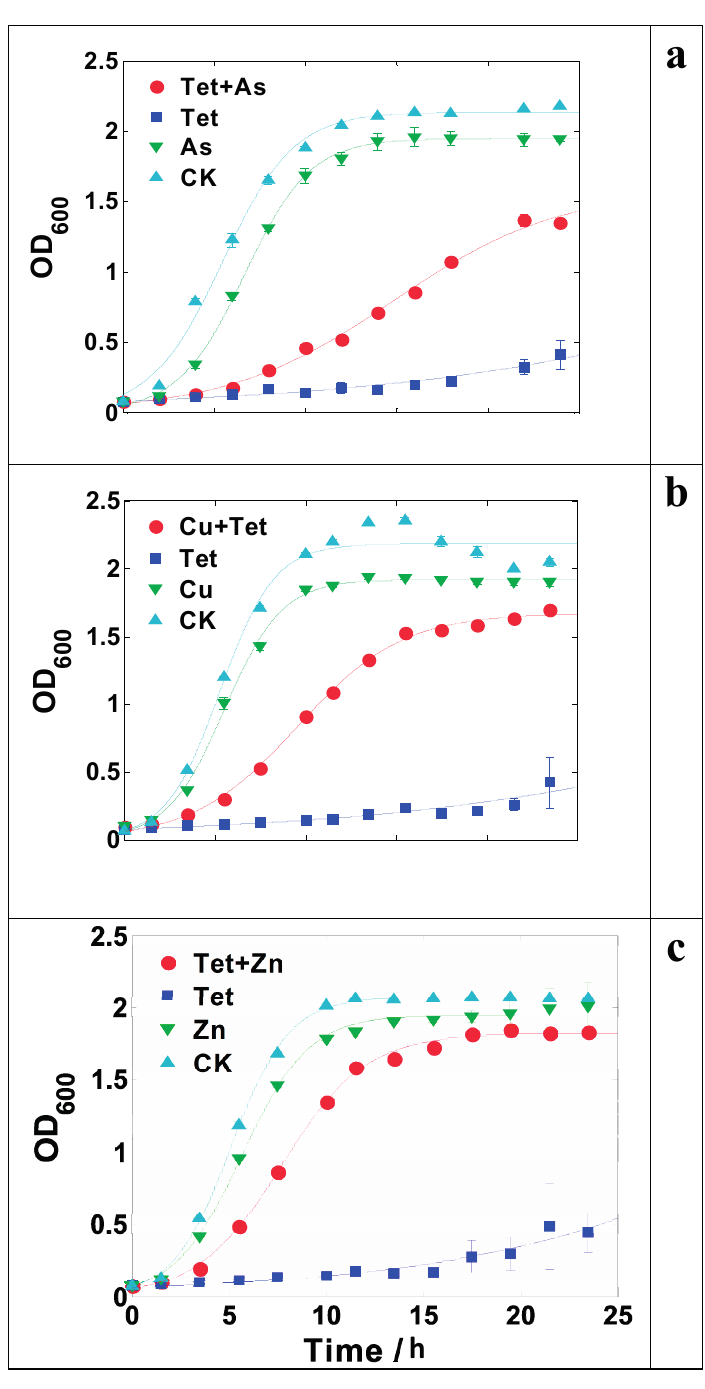
Figure 3. ( a ) Growth curve of LSCJ7 with 2 mM arsenate (As) and/or 24 μ M tetracycline (Tet) treatment; ( b ) Growth curve of LSJC7 with 4 mM copper (Cu) and/or 24 μ M Tet treatment; ( c ) Growth curve of LSCJ7 with 1.25 mM zinc (Zn) and/or 24 μ M Tet treatment. Each point is presented as mean ± SD ( n = 3). Growth curves are fitted by logistic